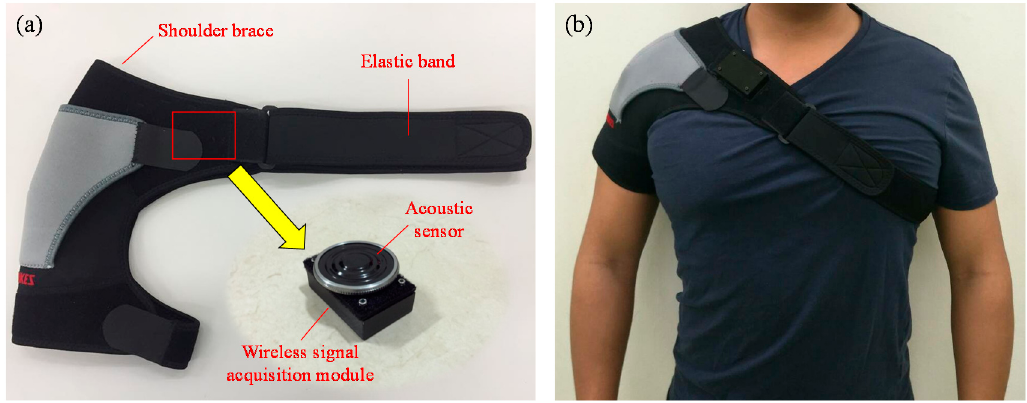
Figure 3. ( a ) Photograph of wearable mechanical design, and ( b ) photograph of wearing the wireless breathing sound monitoring system.